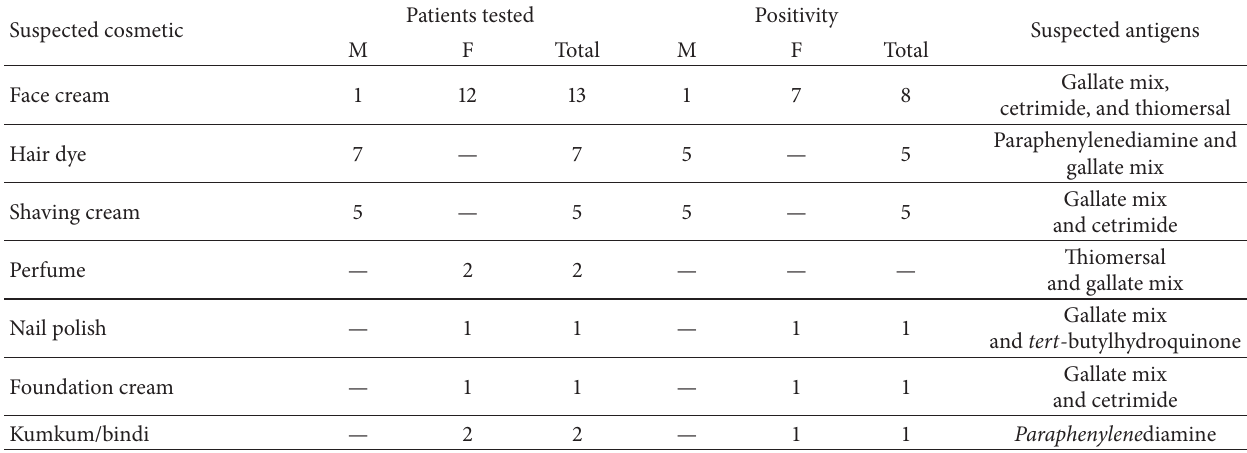
Table 2: Results of patch testing with patient’s own